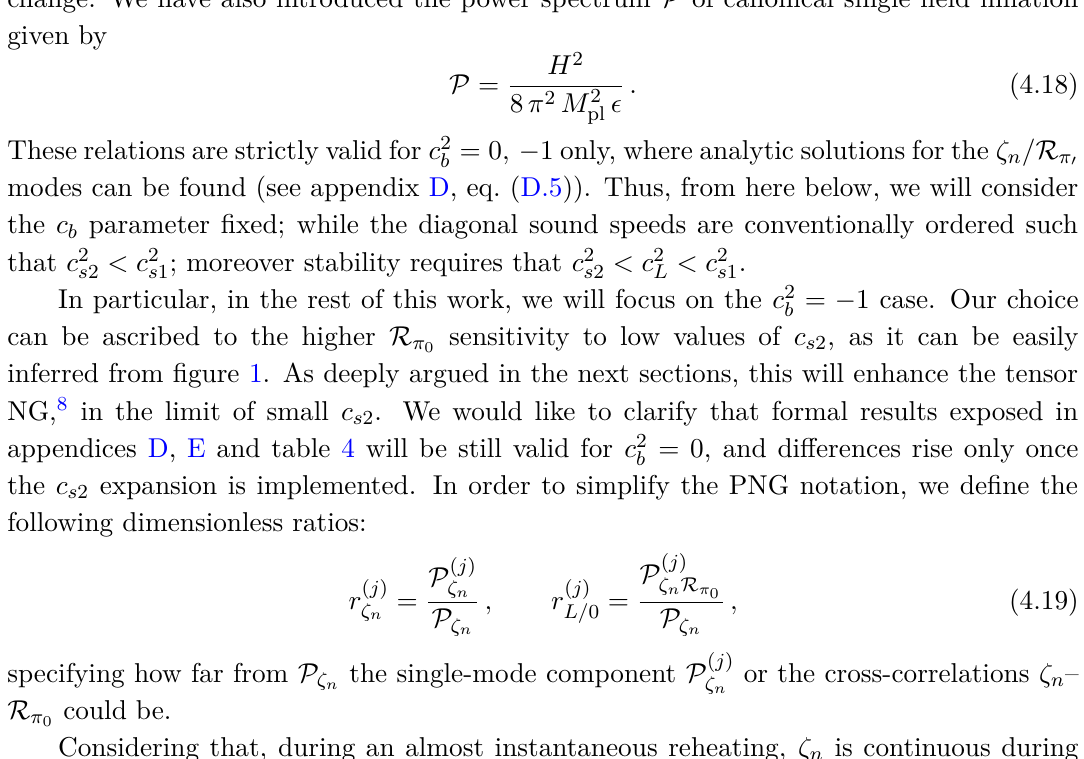
Figure 1 . Log important for c 2